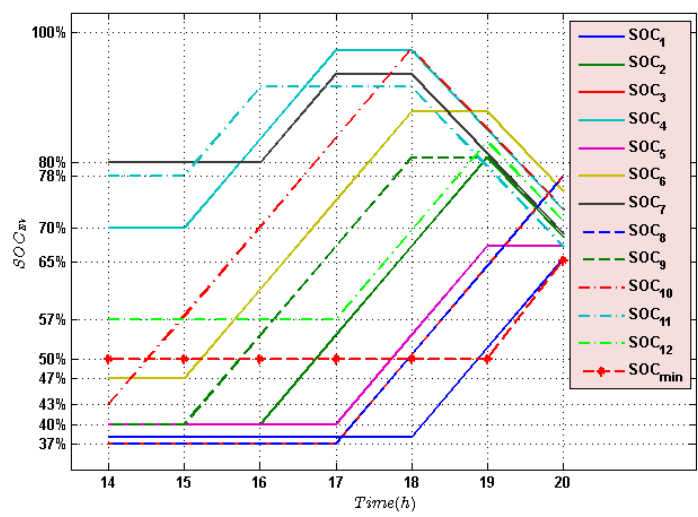
Figure 7. SOC variation of each EV in scenario 3.